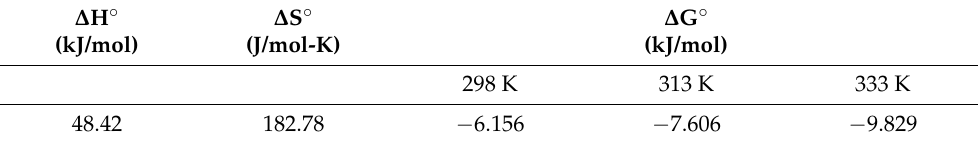
Table 4. Thermodynamic parameters determined for the adsorption of MO on